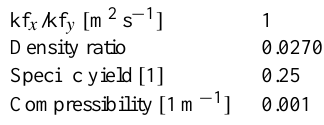
Table 2. Fixed flow parameters. Table 3. Fixed mass transport